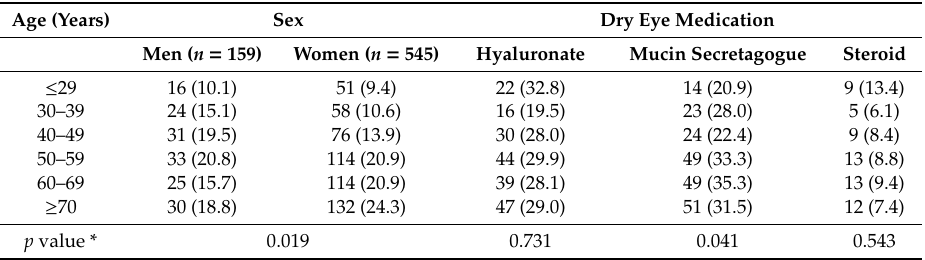
Table 1. Age and sex distribution and dry eye medication of study